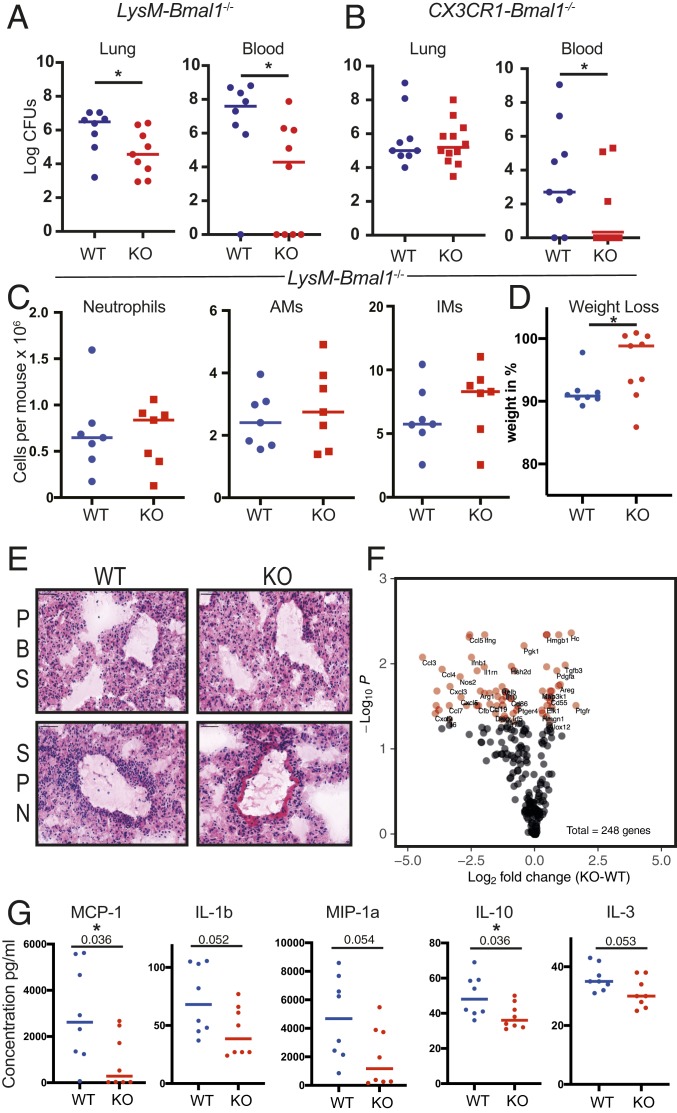
Deletion of BMAL1 in macrophages protects against pneumococcal infection. (A) LysM-Bmal1−/− and (B) CX3CR1-Bmal1−/− mice (knockout [KO]) and floxed littermate controls (WT) were infected with S. pneumoniae at ZT12. The bacterial load in lung and peripheral blood at 48 was quantified (n = 8 to 12, Mann–Whitney U test *P < 0.05). (C) Immune cells were recovered from the lung tissue in A neutrophils, alveolar macrophages (AMs), and interstitial macrophages (IMs). (D) Weight loss after 48 h (Mann–Whitney U test *P < 0.05). (E) Representative lung histology with H&E staining. (Scale bar, 50 µm.) SPN, Streptococcus pneumoniae. (F) Cytokine analysis of lung tissue from A was performed using a NanoString inflammatory gene panel (see also SI Appendix, Fig. S1F). Each of the 248 genes is marked, and those that statistically differ by genotype are marked in red, with gene abbreviation. (G) Multiplex cytokine analysis of tissue from A (n = 8, t test, exact P value marked, and *P ≤ 0.05).